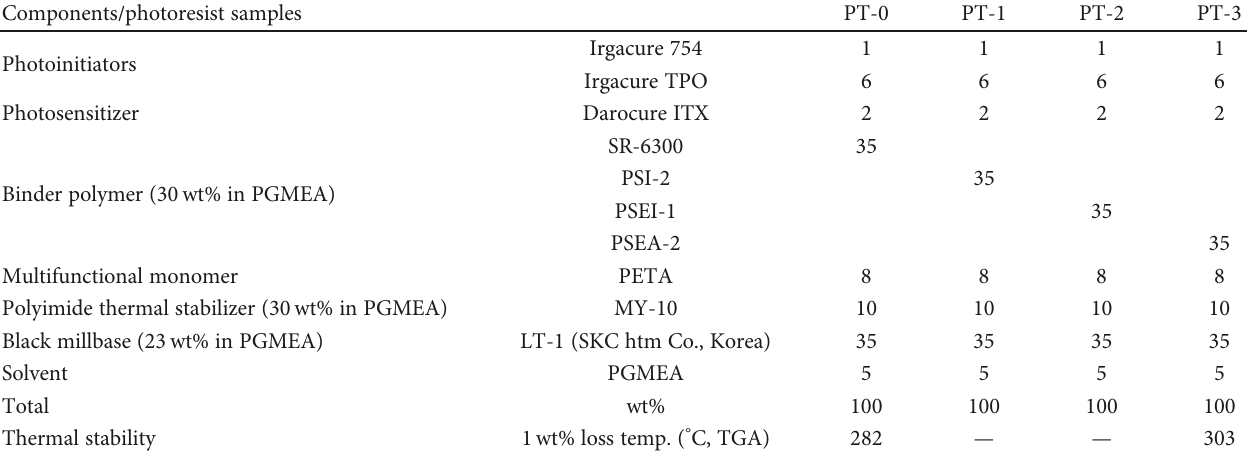
Table 2: Formulation of black photoresists and thermal stability of a black PDL pattern [14].